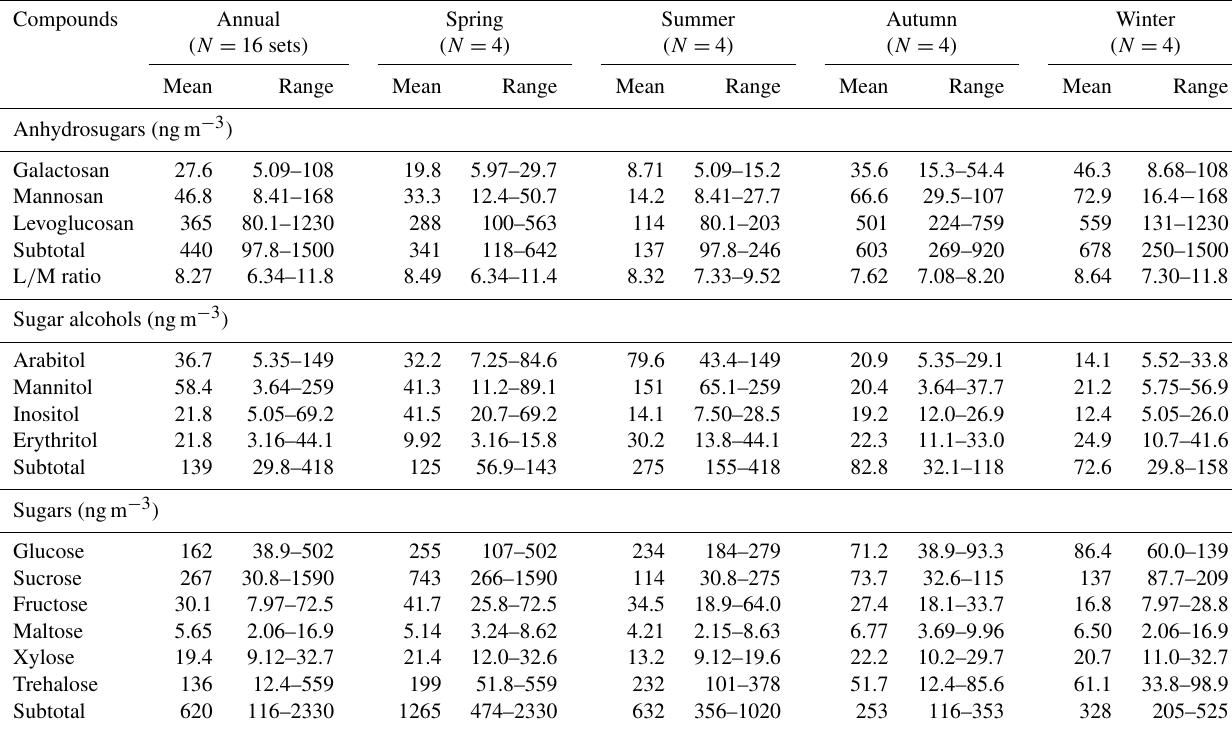
Table 1. Abundances (ngm − 3 ) and seasonal variations in anhydrosugars and other saccharides in size-segregated aerosols in urban Beijing from April 2017 to January 2018. In total 16 sets of size-segregated samples were analyzed; each set contains nine samples.